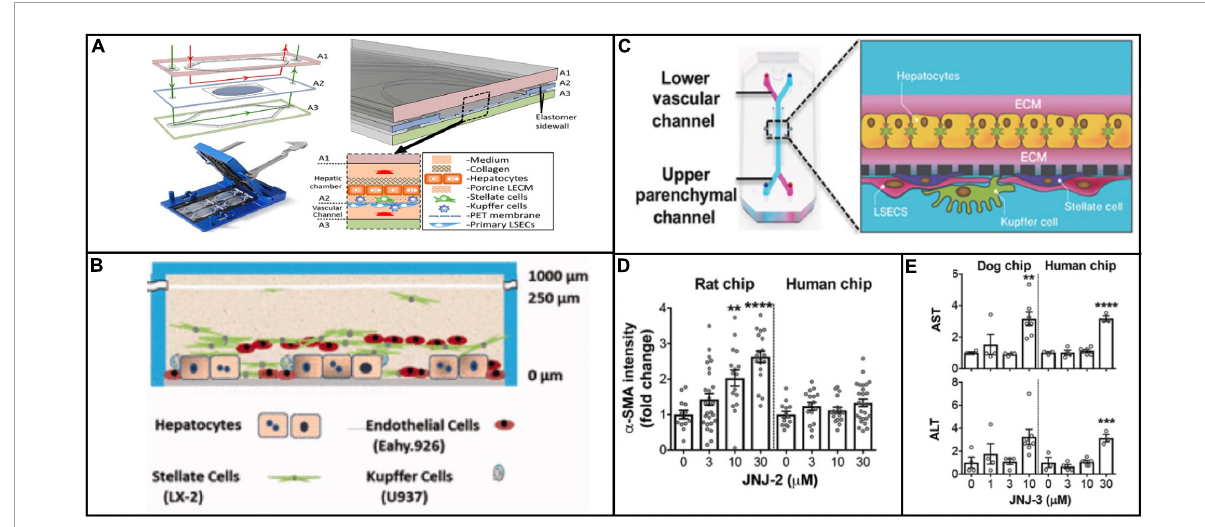
FIGURE3 Examples of platforms that incorporate multiple cell types that are implicated in viral hepatitis pathogenesis. The platforms described in Li et al. (2018) (Reproduced with permissions from Li et al.) (A) , Vernetti et al. (2016) (Reproduced with permissions from Vernetti et al.) (B) , and Jang K. J. et al. (2019) (Reproduced with permissions from Jang et al.) (C) all include Kupffer cells and hepatic stellate cells in addition to hepatocytes and endothelial cells. The inclusion of all four cell types makes these platforms more effective for modeling a systemic response to viral infection. Jang et al. demonstrated that treatment of rat and human cells with a proprietary compound resulted in differential toxicity (D) , but treatment of dog and human cells with a different compound resulted in a similar toxicity profile (E) , evidence of the variation in responses between animal and human cells to different compounds. ** P < 0.01, *** P < 0.001, and **** P <